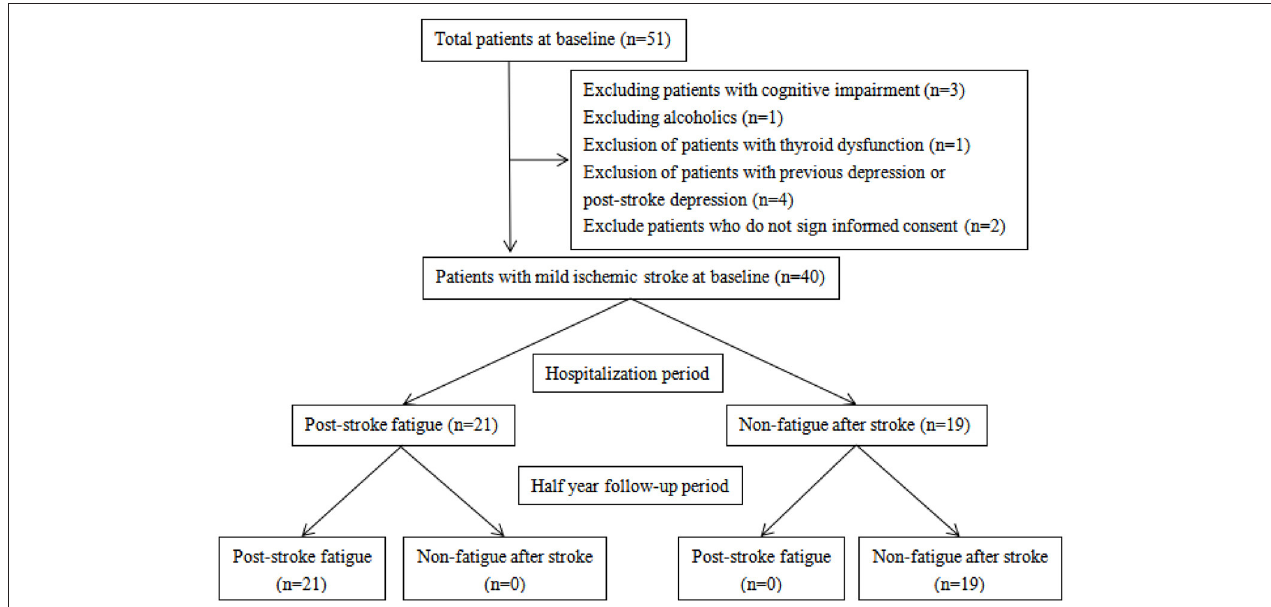
FIGURE 1 | Flow chart showing patient